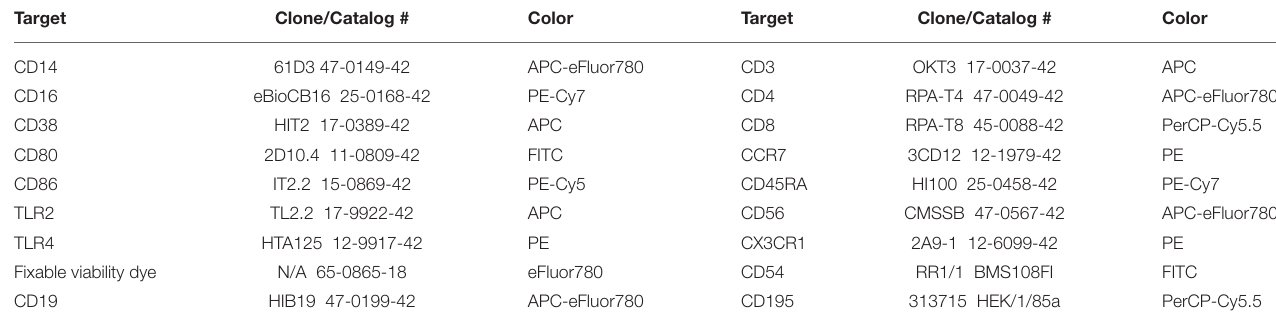
TABLE 2 | Antibodies for flow cytometry